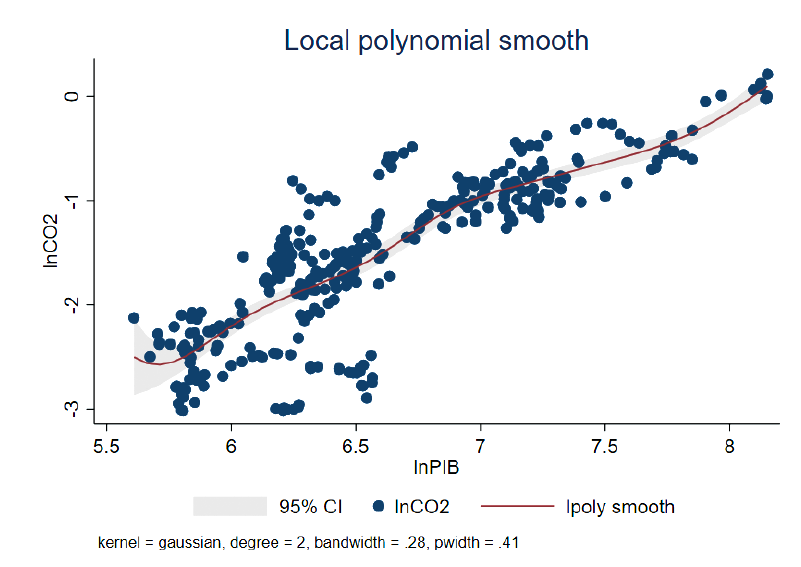
Figure 1. Partial adjustment of the income-CO2 emission